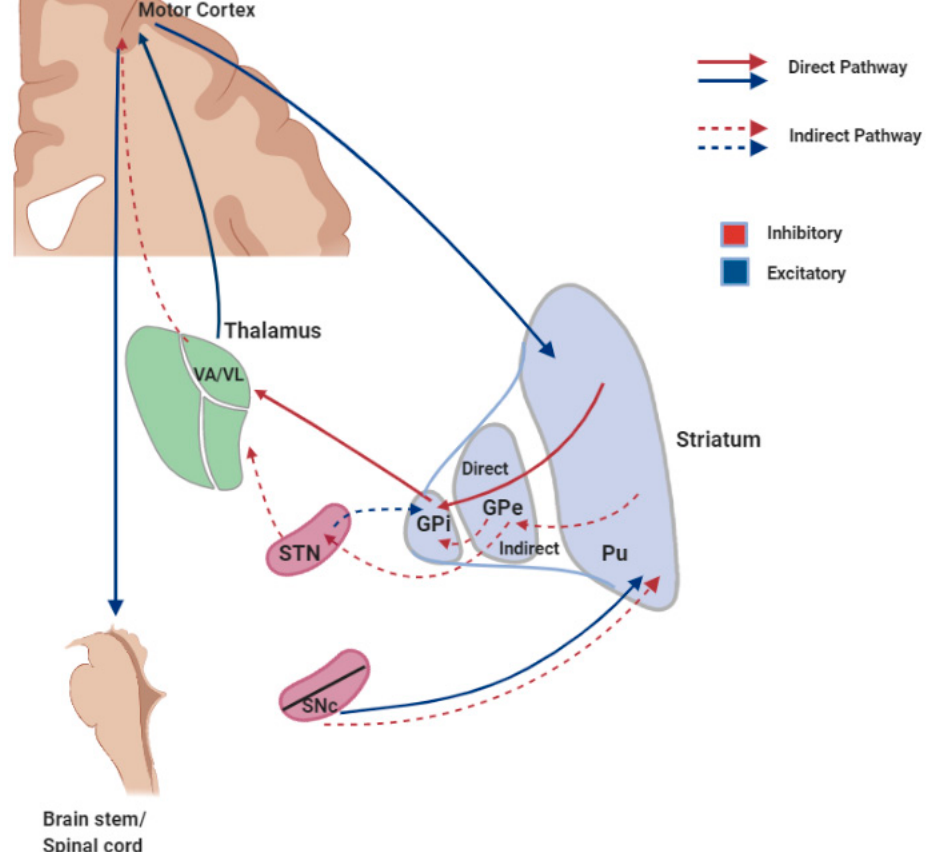
Figure 2. Schematic drawing of the direct and indirect pathways for motor control. Solid and faded lines represent direct and indirect pathways, respectively. Blue lines represent excitatory connections and red lines represent inhibitory connections. Pu = putamen, Gpe = globus pallidus externus, Gpi = globus pallidus internus, STN = subthalamic nucleus, SNc = substantia nigra pars compacta, VA/VL = ventral anterior/ventral lateral thalamic nucleus. Created with BioRender.com.